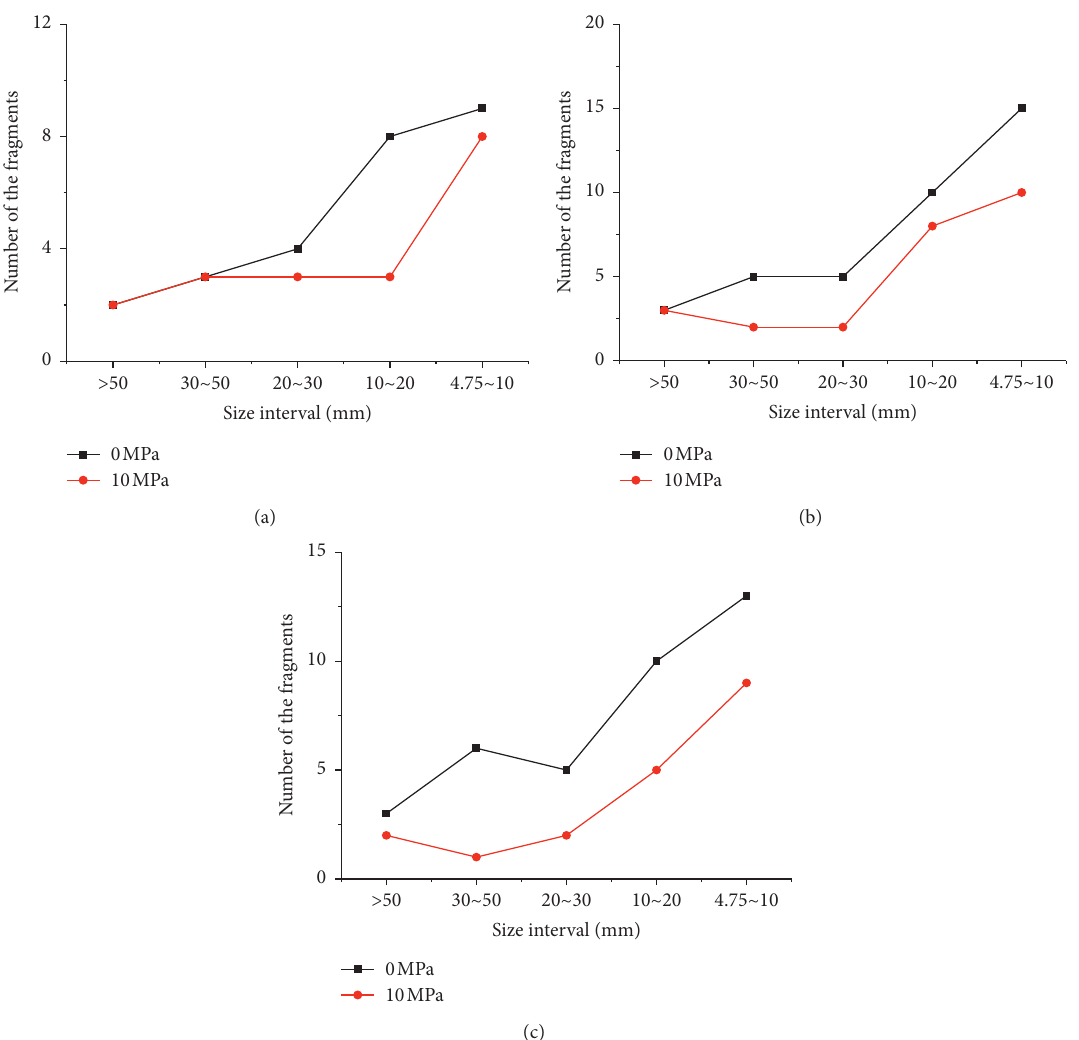
Figure 15: Number of limestone specimen fragments in different size intervals obtained under different confining pressures. (a) Con- ventional compression test. (b) Cyclic loading test with a frequency of 0.25Hz. (c) Cyclic loading test with a frequency of